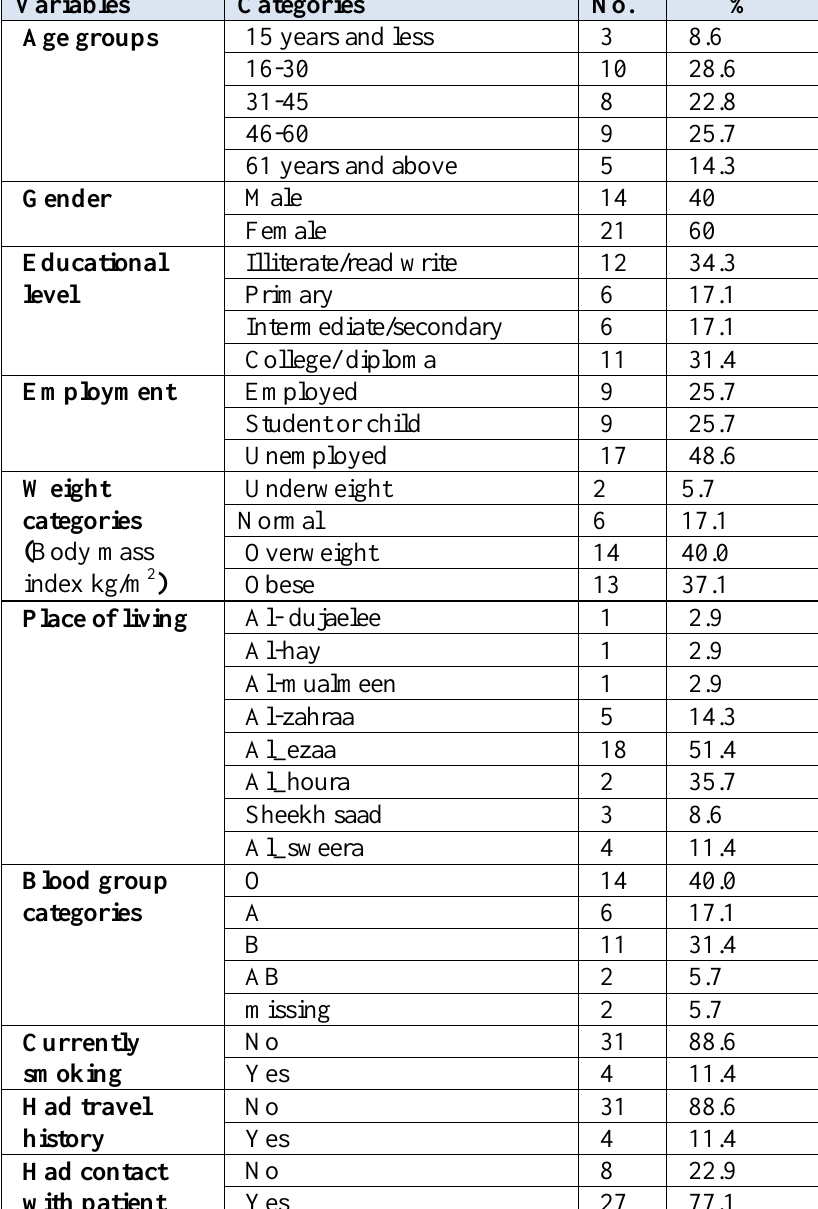
Table (1): Socio-demographic features and risk factors of COVID-19 patients